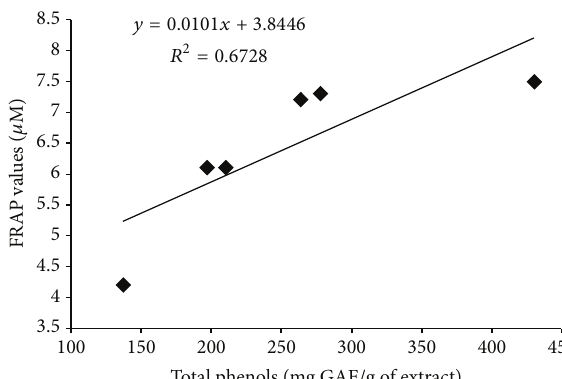
Figure 6: Correlation between total phenols and FRAP of bark extracts of Loranthus pulverulentus .